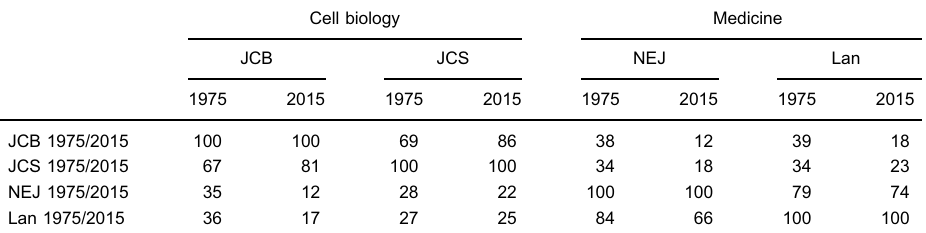
Table 3. Similarity indices between vocabulary in titles and abstracts of articles from cell biology and medicine journals between the years 1975 and 2015. Cell